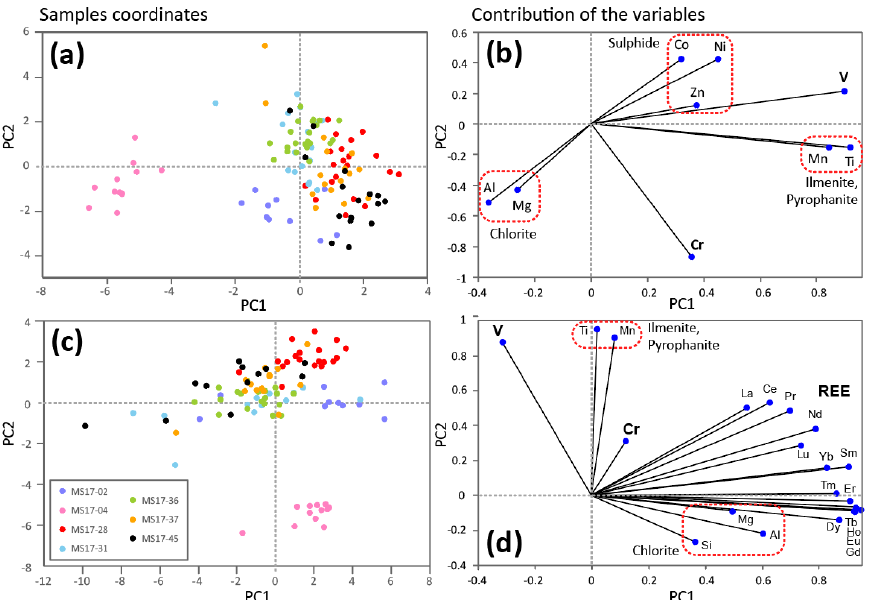
Figure 13. Results of principal component analysis (PCA) performed on ( a , b ) 9 and ( c , d ) 12 elements analyzed in the magnetite by LA-ICP-MS. The PC1 vs. PC2 binary diagrams display (a, c) the location of the analyses and (b, d) the contribution of each variable. PC1 and PC2 explain, respectively, 41% and 24% (PCA performed on 9 elements), as well as 41% and 26% (PCA performed on 12 elements) of the variance.